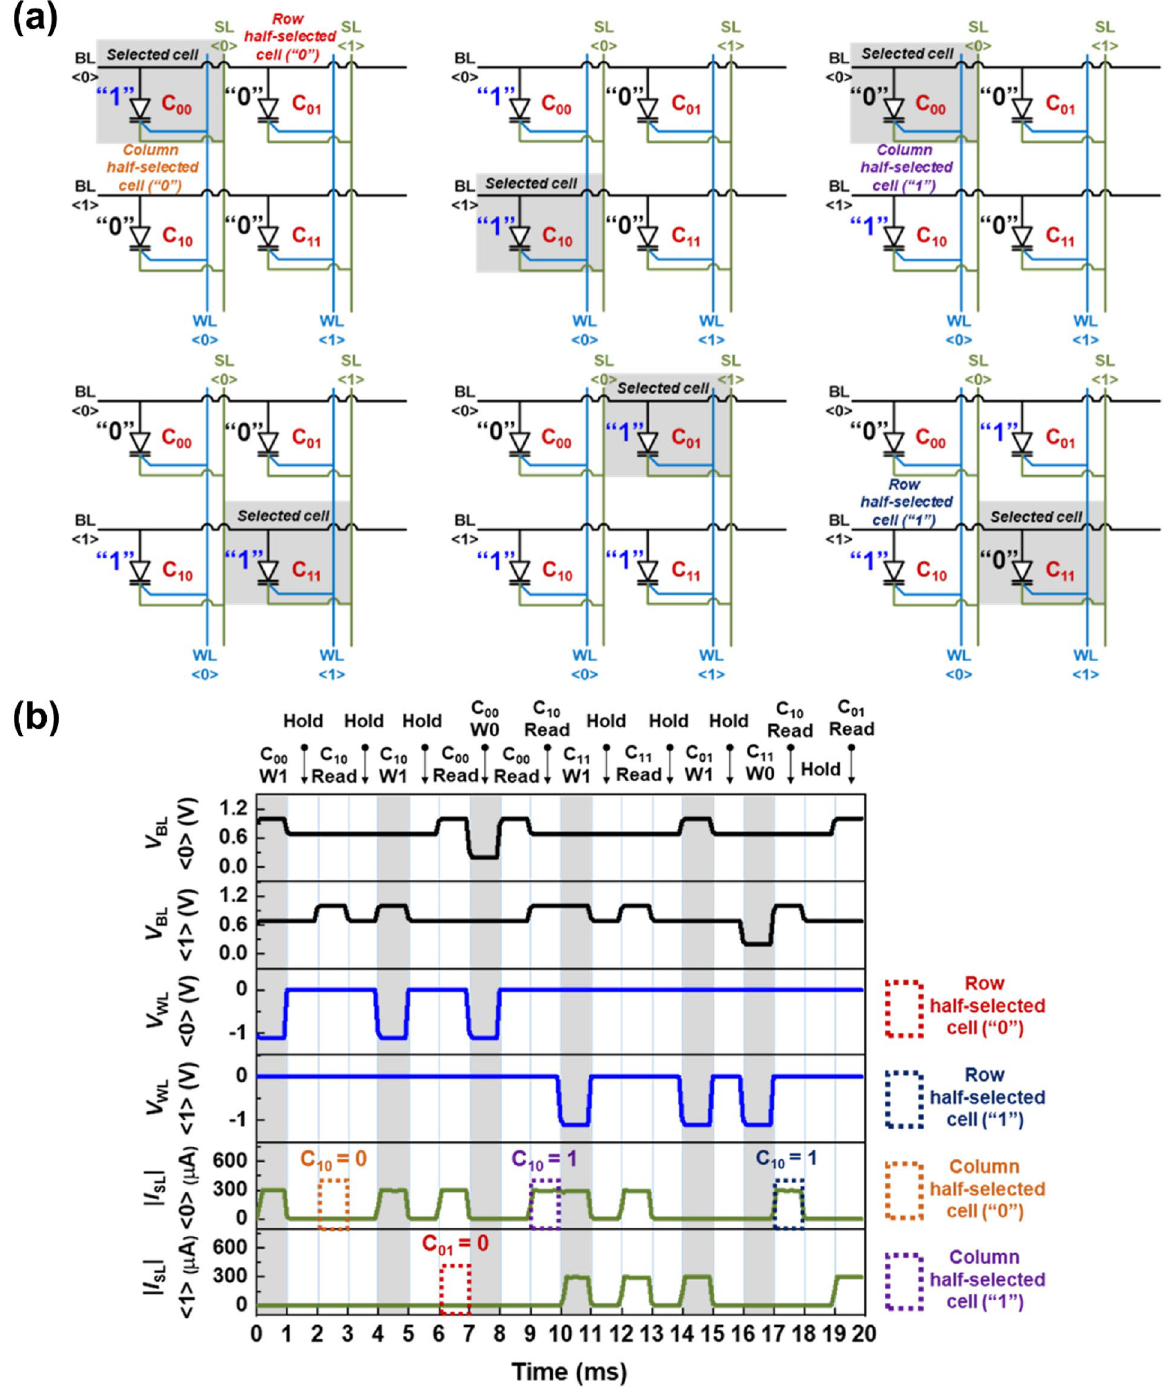
Figure 6. For 2 × 2 1T-SRAM cell array: ( a ) schematic diagram of the memory operations and ( b ) timing